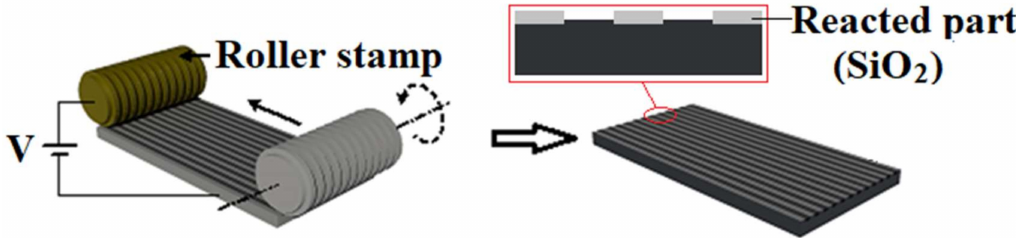
Figure 2. Schematic of the proposed rolling NEL system.